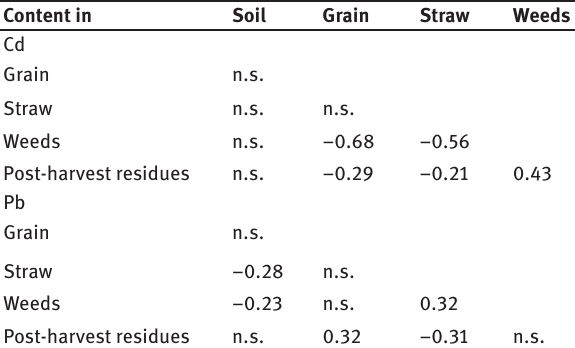
Table 9: Simple correlation coefficients calculated between the cadmium and lead content in soil and plant biomass. Content